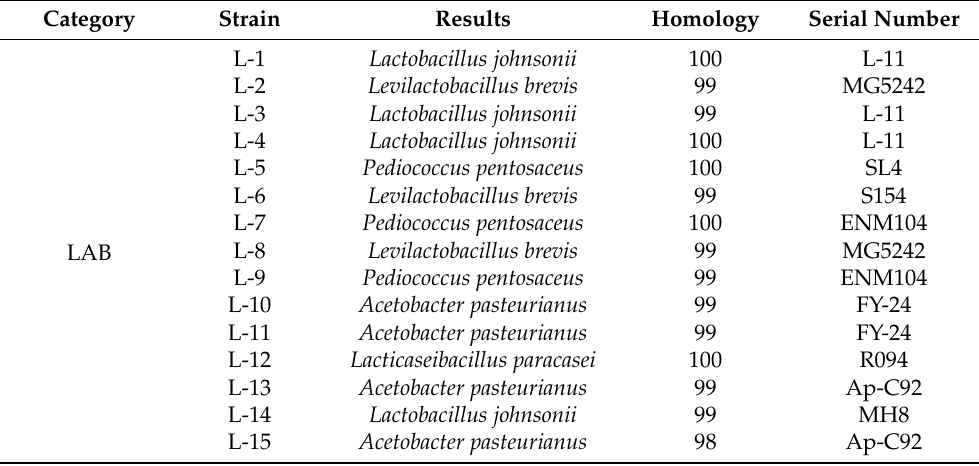
Table 2. Identification results of yeasts and